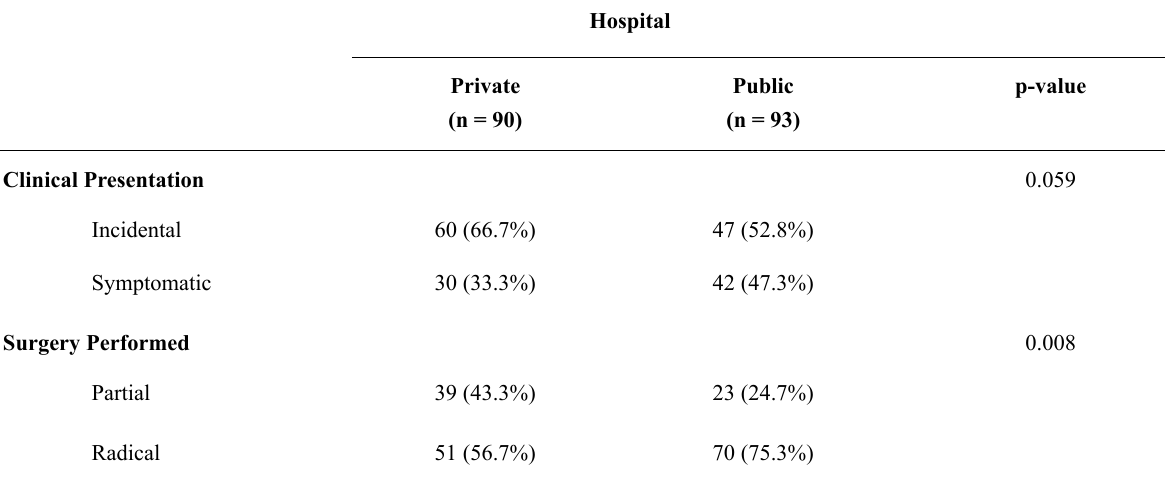
Table 2 - Clinical presentation of RCC and type of surgery performed.